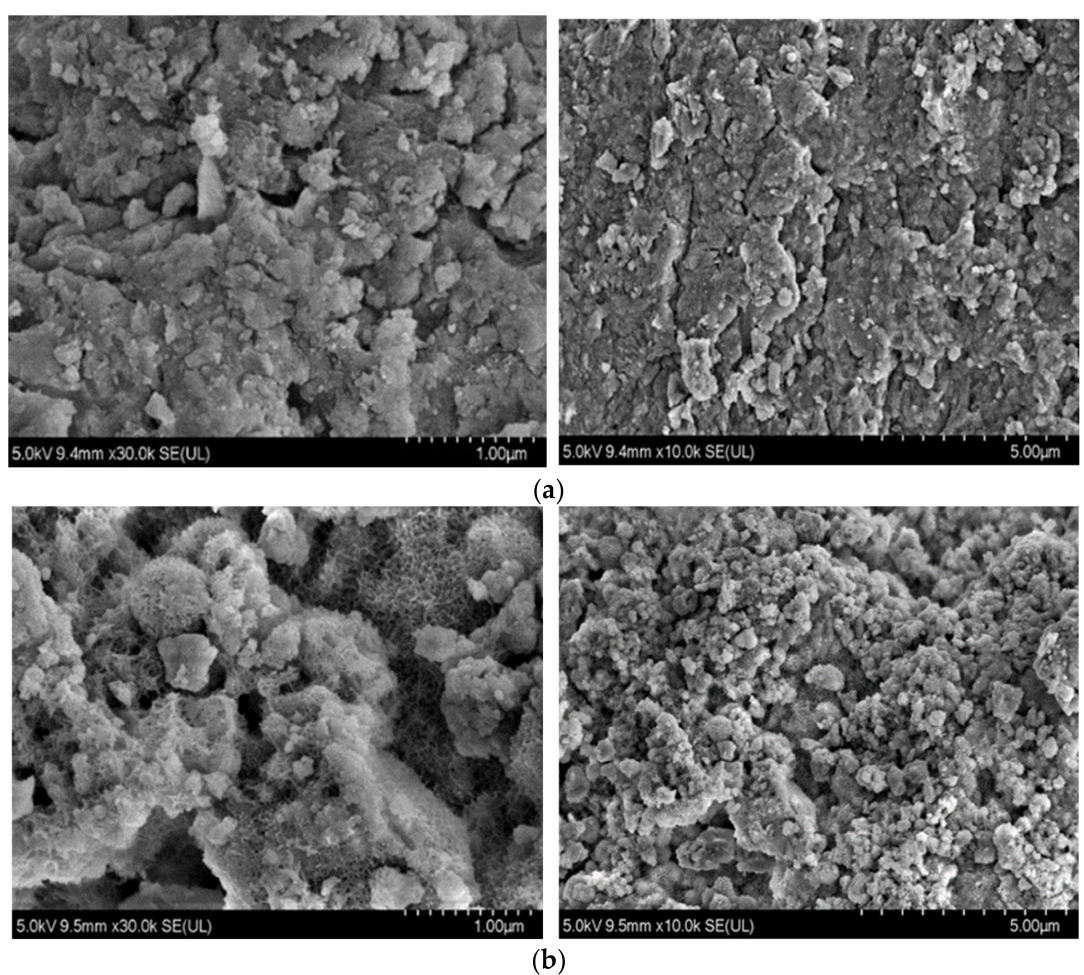
Figure 3. SEM image of composite adsorbents. ( a ) Before adsorption 30,000 × ; before adsorption 10,000 × . ( b ) After adsorption 30,000 × ; after adsorption 10,000 ×